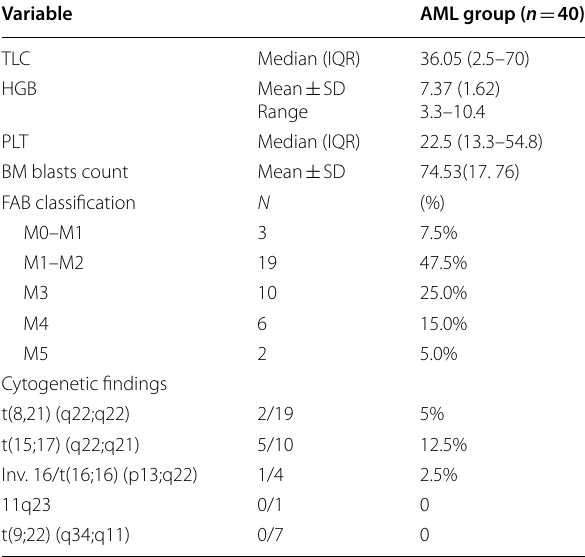
Table 1 Laboratory characteristics of the studied patients Table 3 Comparison between AML cases vs. control group